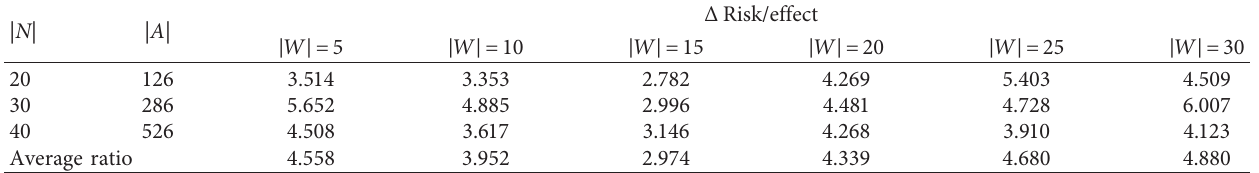
Table 9: Result of experiments with varied |W|, when α � 0.1, β � 0.1, and λ � 0.7.